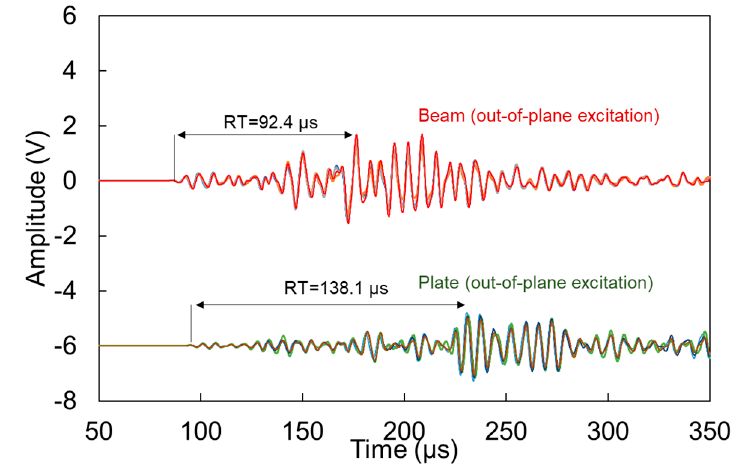
Figure 7. Waveforms received after pencil lead excitation on the surface of the specimens for beam and plate geometries.